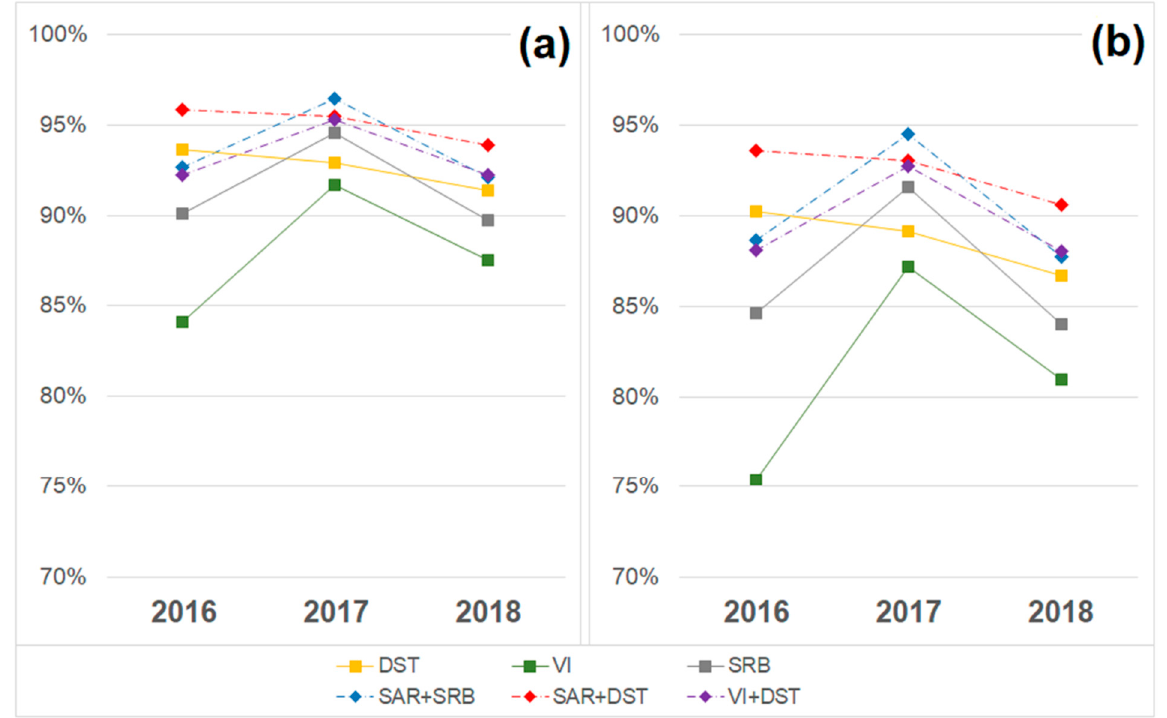
Figure 4. ( a ) Overall Accuracy and ( b ) Kappa coefficient for the best classification maps from the different approaches proposed across the three years analyzed. Full lines represent approaches using features from a single spectral region, while dashed lines represent data-fusion approaches.